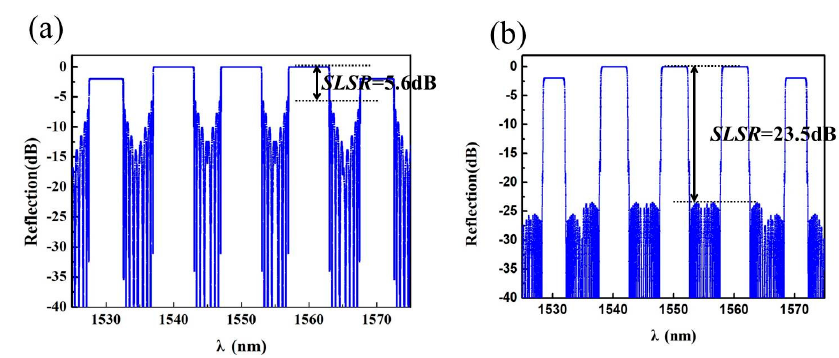
Figure 8. Reflection spectrum of ( a ) traditional sampled grating; ( b ) the proposed apodized sampled grating when N = 5 and t = 0.5.